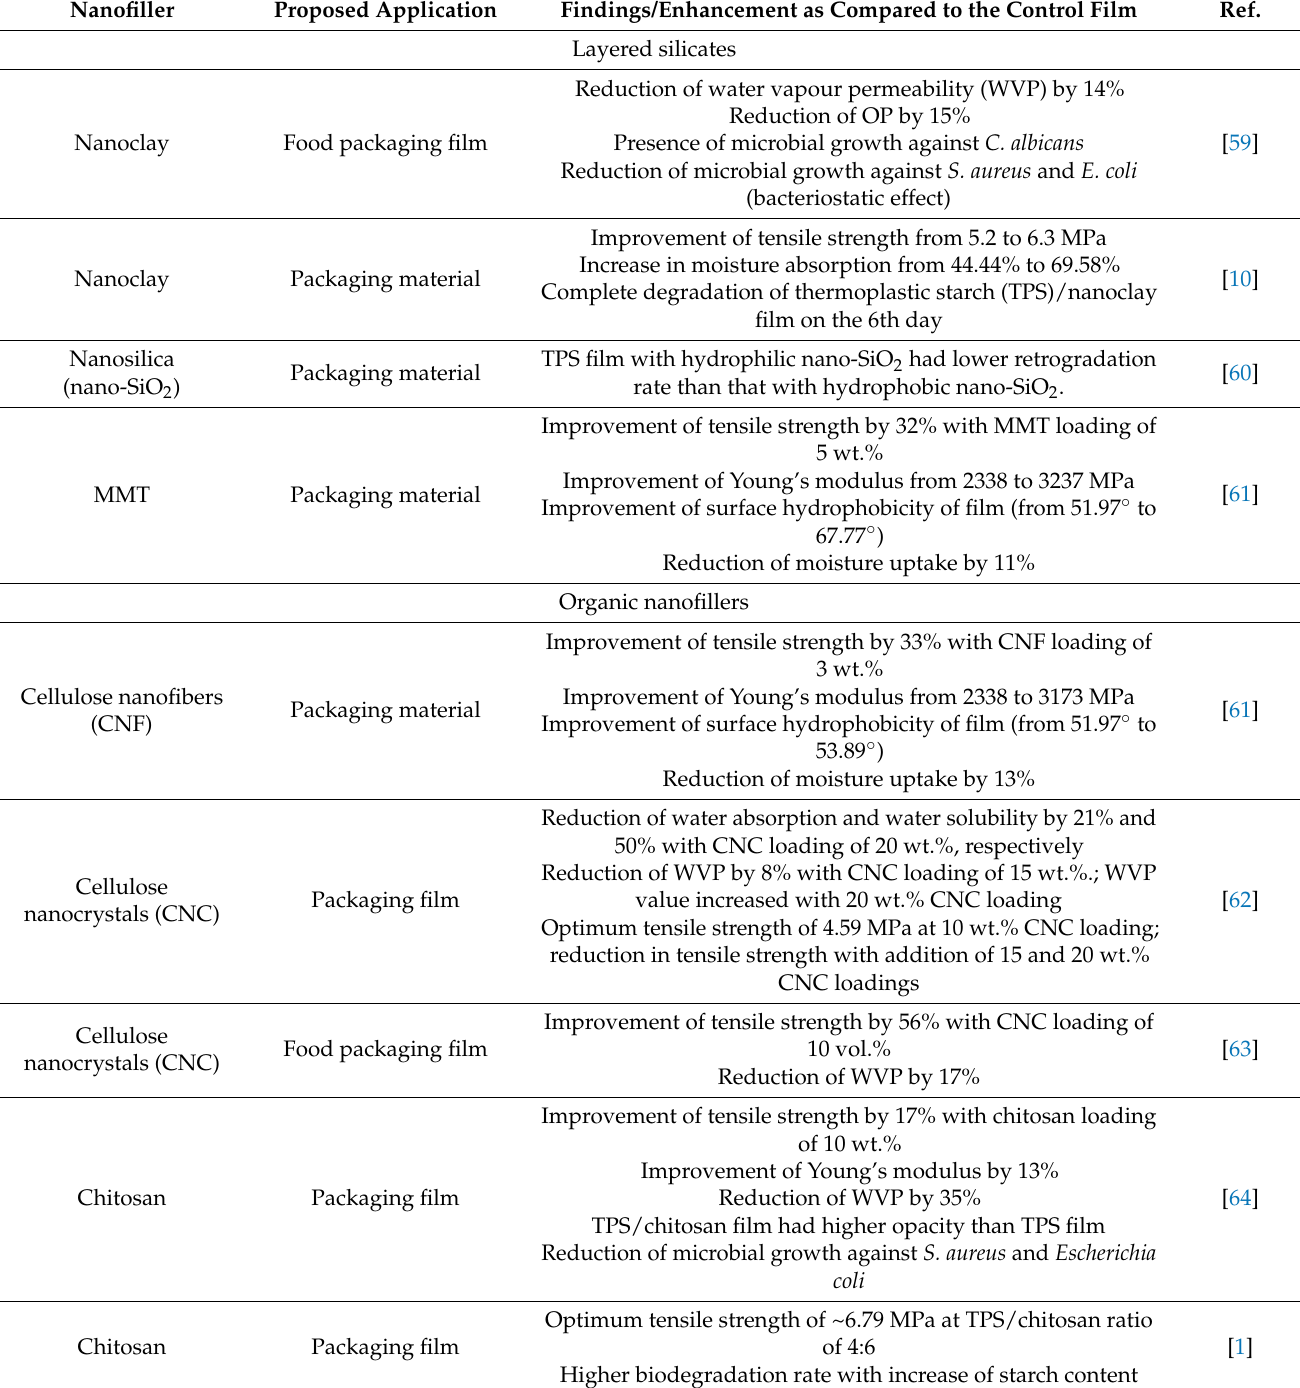
Table 1. List of nanofillers incorporated in starch-based films with the reported findings or properties